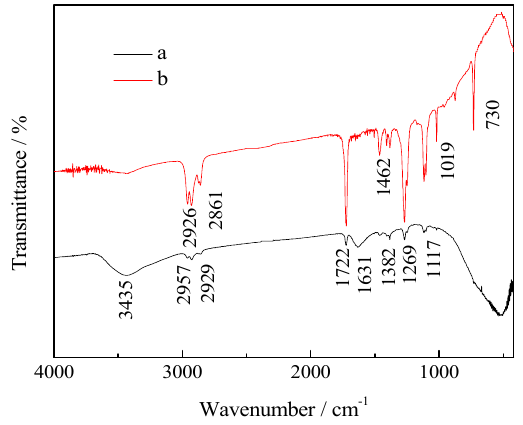
Figure 11. Fourier Transform Infrared Spectroscopy (FTIR) spectra of samples: ( a ) 0.75% La/TiO 2 ; ( b ) photocatalytic degradation of benzohydroxamic acid by 0.75% La/TiO 2 after 2 h.